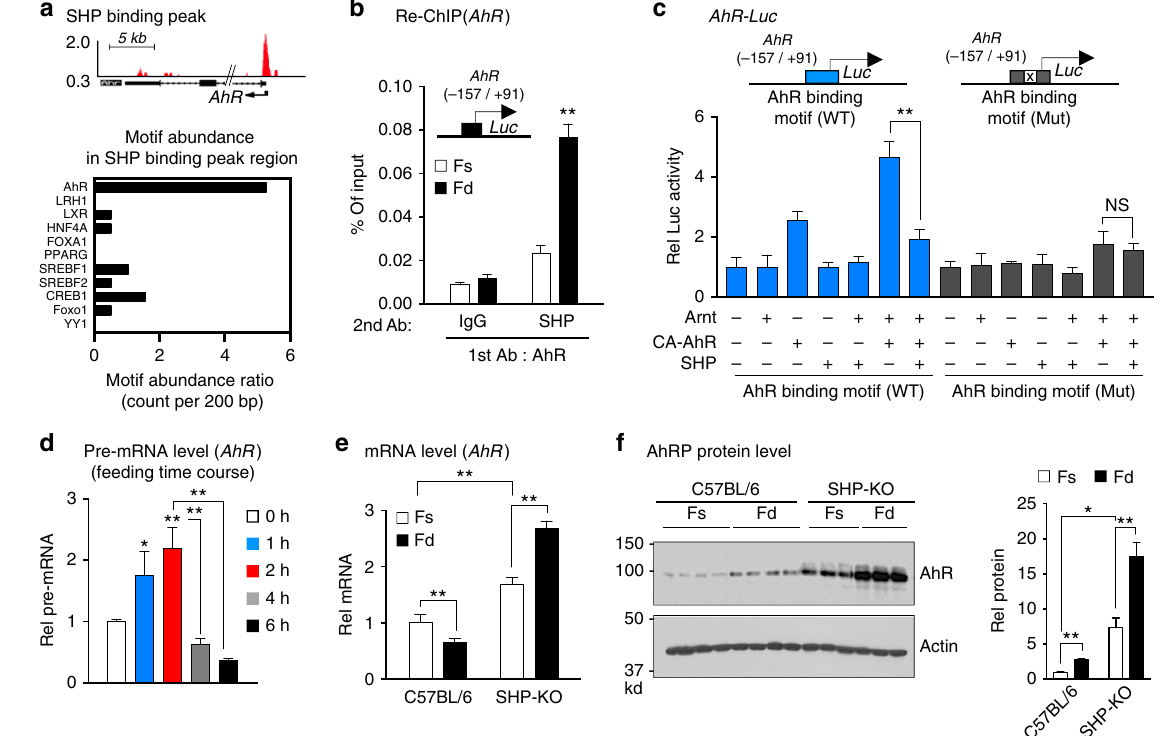
Fig. 5 AhR induces its own expression and SHP inhibits the AhR function. a SHP binding peak at the AhR promoter from published ChIP data and potential binding sites for transcription factors (bottom) within SHP peak region (top) were identi fi ed using the JASPAR database. b Mice ( n = 5 mice per group) were refed for 6 h after fasting overnight. Liver chromatin was immunoprecipitated with AhR antibody fi rst and then eluted and re-precipitated with SHP antibody. c Hepa1c1c7 cells were transfected with indicated plasmids. After 2 days, cells were treated with FGF19 for 1 h, and luciferase activities were measured and normalized to β -galactosidase activity ( n = 5). d Mice ( n = 5 mice per group) were fasted overnight or fasted and refed for the indicated times, and AhR pre-mRNA levels were determined by qRT-PCR. e , f C57BL/6 control mice and SHP-KO mice ( n = 3 – 5 mice per group) were fasted overnight (Fs) or fasted and refed for 6 h (Fd). Hepatic mRNA ( e ) and proteins ( f ) levels were determined. Full size immunoblots are in Supplementary Figure 12b. Means ± SD are shown, and statistical signi fi cance was measured using the c , d one- or b , e , f (right) two-way ANOVA with the FDR post-test. * P < 0.05, ** P < 0.01, NS, statistically not signi fi